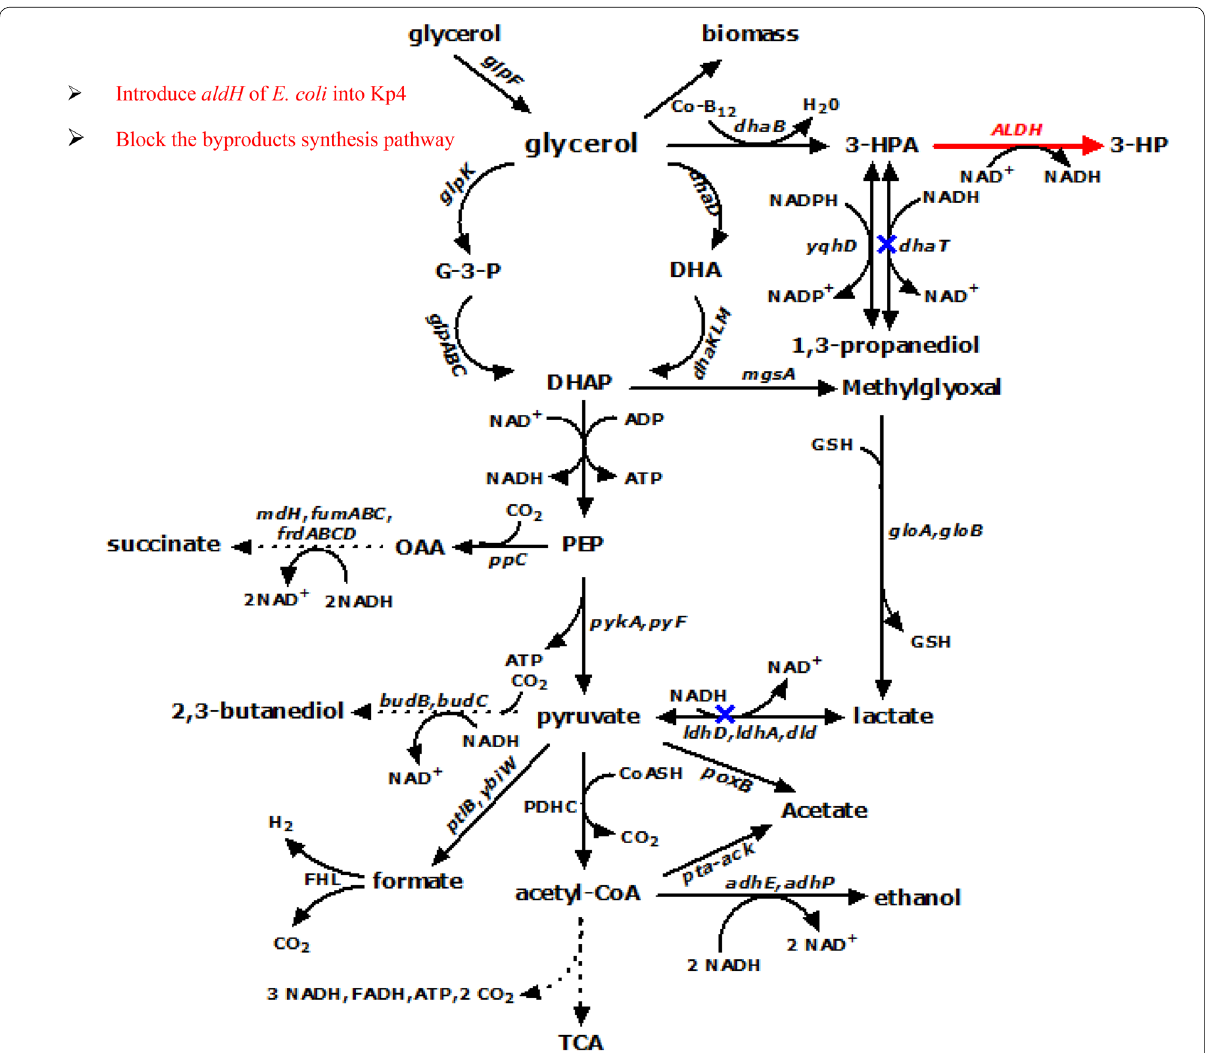
Fig. 1 The metabolic pathways of glycerol in K. pneumoniae . Overexpressed gene (rightwards arrow), knocked out gene (multiplication